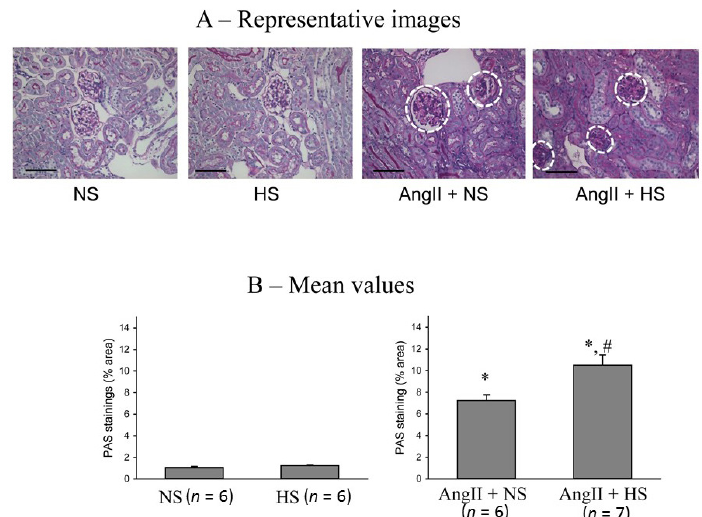
Figure 8. Glomerulosclerotic changes in the kidneys (PAS staining of renal slices). (A) the representative images of glomerulosclerotic changes (white dashed circle) and (B) the mean values of percent area of PAS staining. The scale bar indicates 100 µm; * : P < 0.01 vs. NS; #: P < 0.05 vs. AngII +